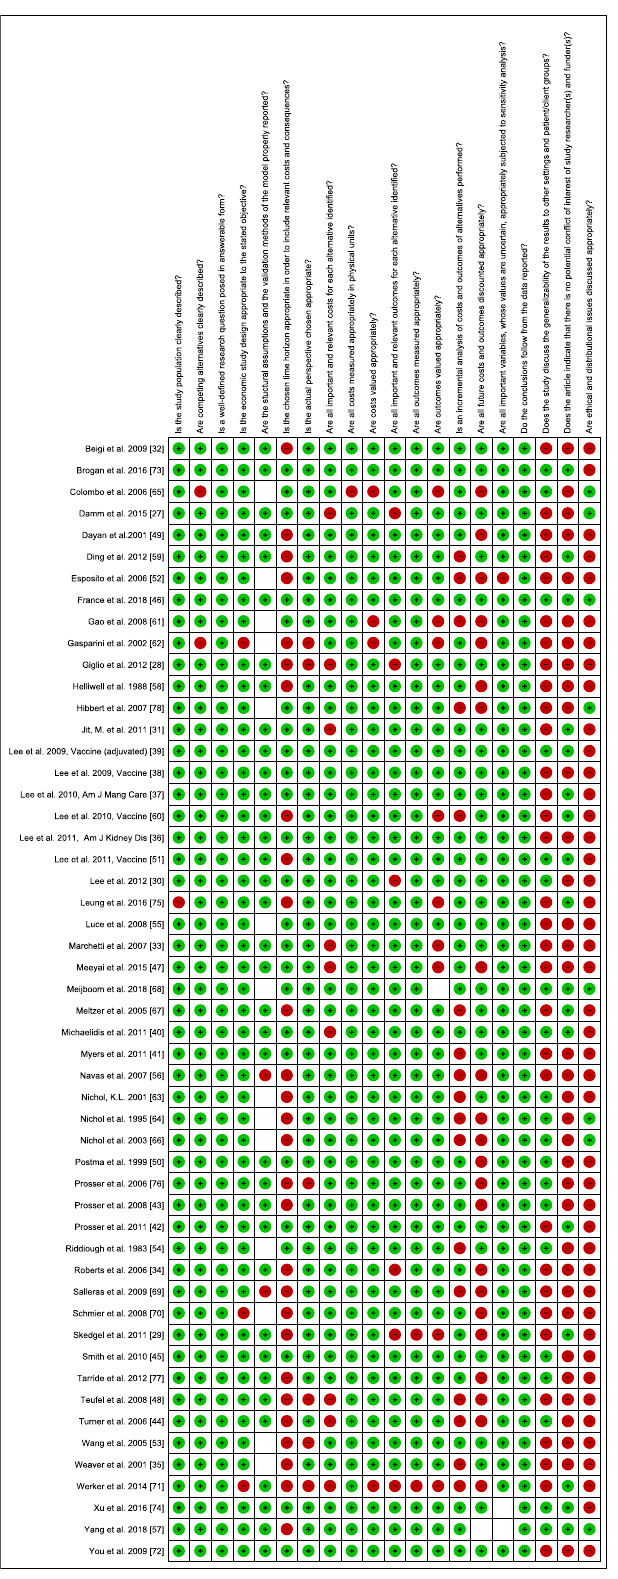
Figure A3. Risk of bias for each individual study, displaying the 20 questions from the Consensus Health Economic Criteria (CHEC) extended list for quality assessment of economic evaluations.